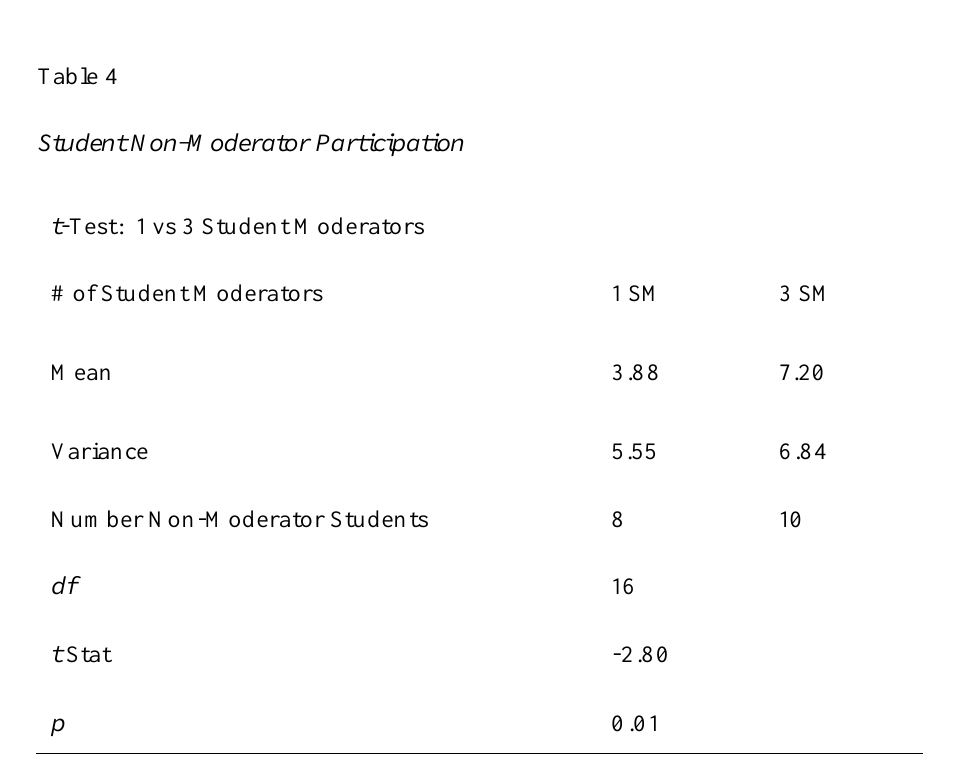
Student Non-Moderator Participation t -Test: 2 vs 3 Student